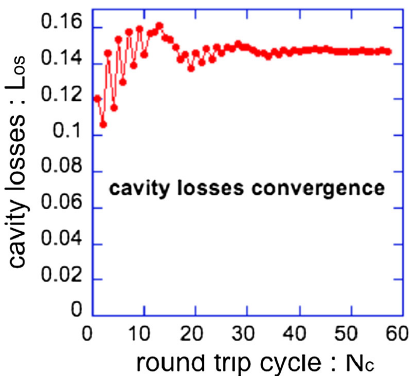
FIG. 2. Typical convergence of cavity losses vs cavity round trip N . c